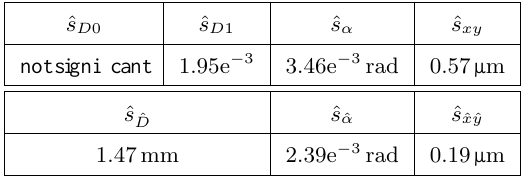
Table 2: A-posteriori standard deviations ˆ s of the original and the adjusted